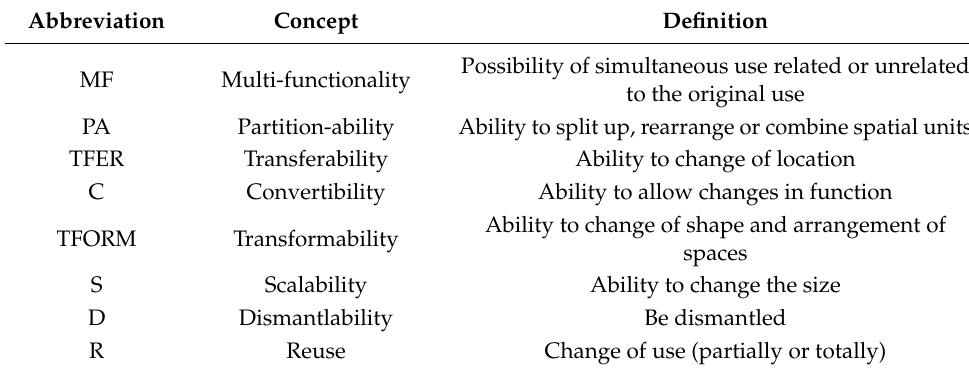
Table 1. Basic concepts related in the research. Own elaboration from